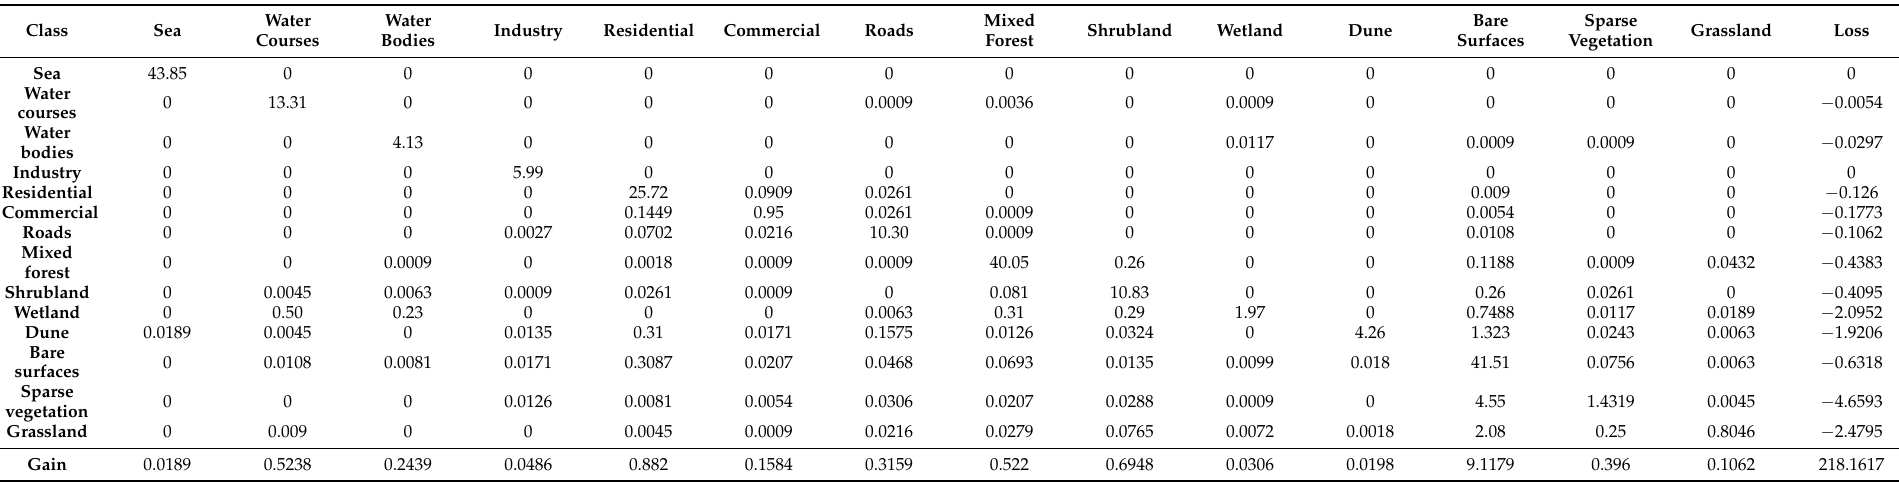
Table A2. LULC matrix representing the class transitions. Units in km 2